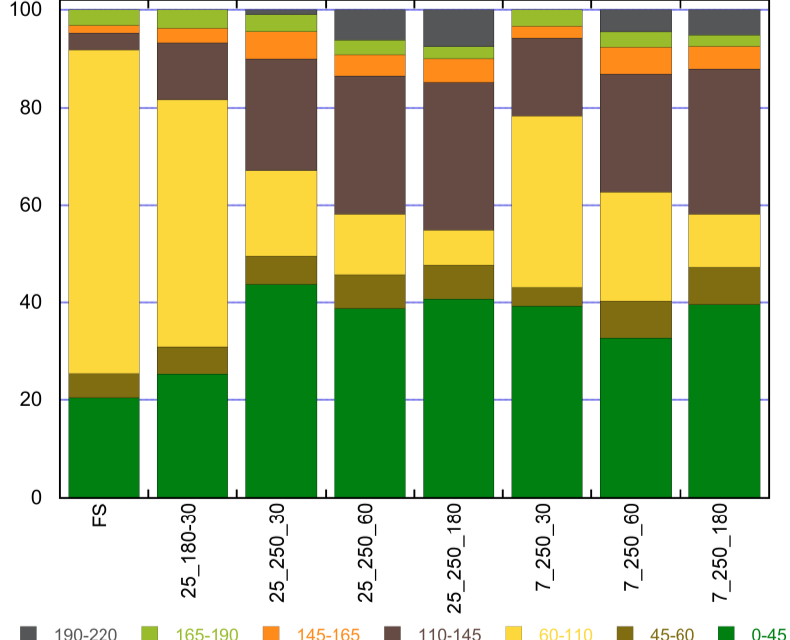
Figure 3. Relative integral intensities of signals in the indicated spectral regions of 13 C CP-MAS NMR spectra of FS and hydrochar samples.